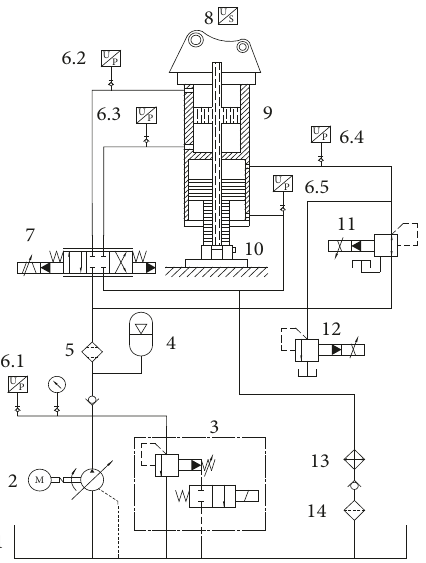
Figure1:Thehydraulicschematicdiagramofthetracksubgradetest device. (1) Oil tank. (2) Constant pressure variable pump. (3) Safety valve. (4) Accumulator.(5) Inlet filter. (6) Hydraulic pressure sensor. (7) Servo valve. (8) Displacement sensor. (9) Double-ring servo cylinder. (10) Load sensor. (11) Three-way proportional pressure reducingvalve.(12)Electromagneticoverflowvalve.(13)Cooler.(14) Oil return